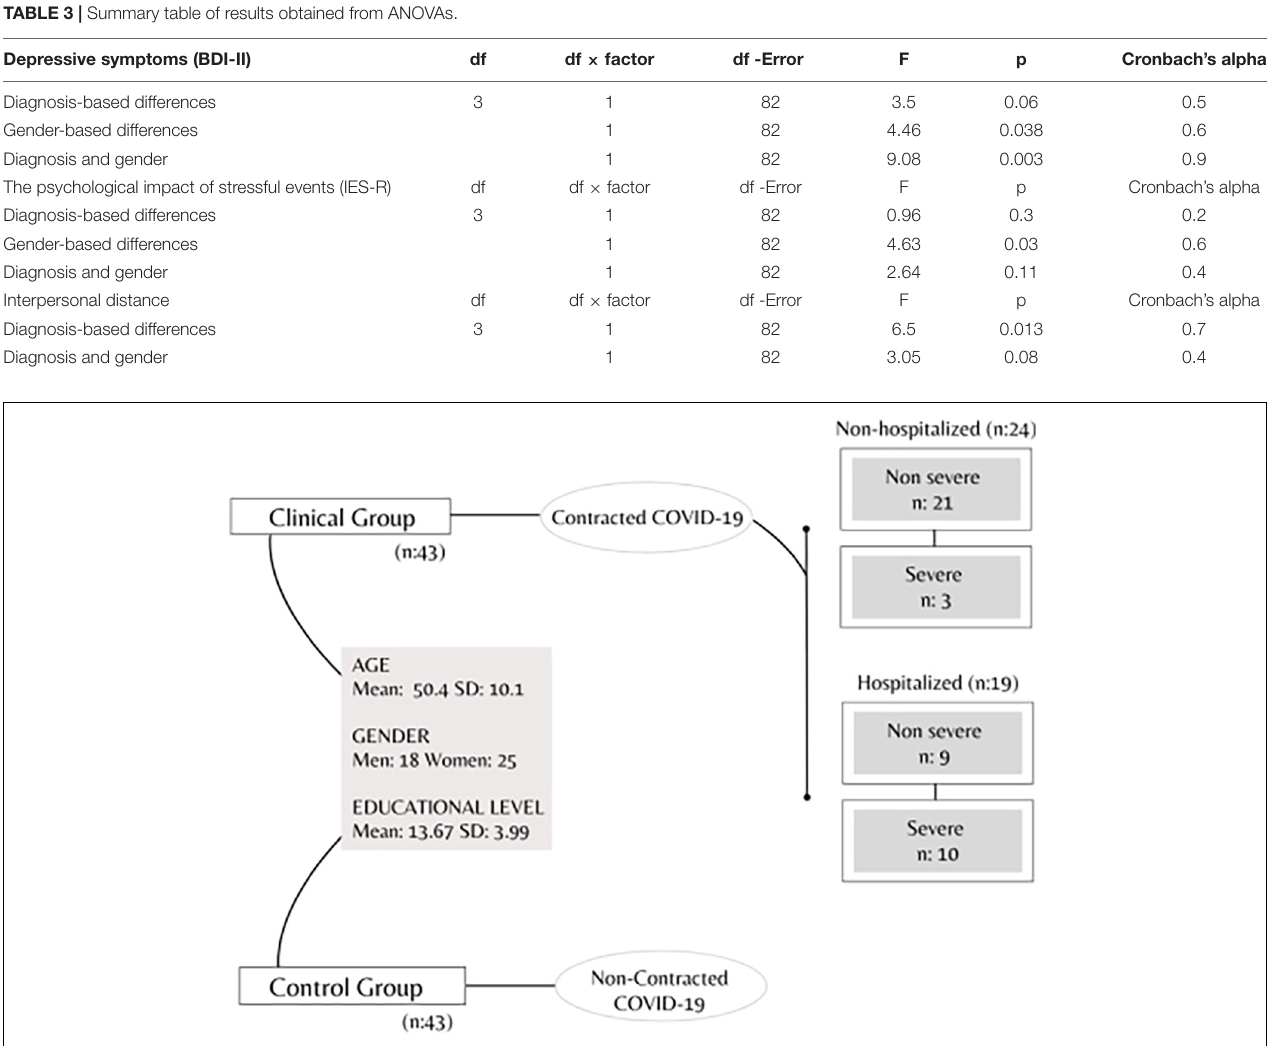
TABLE 3 | Summary table of results obtained from ANOVAs.